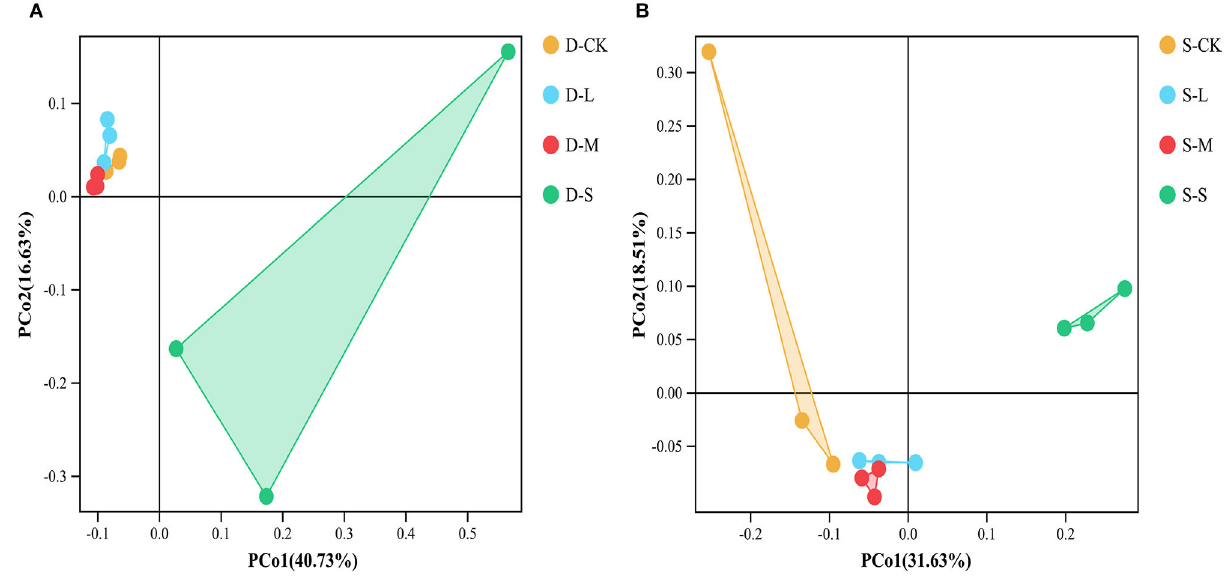
same connectivity as Lysobacter_yangpyeongensis and Sphingomonas _sp, they were not the dominant species of the soil bacterial